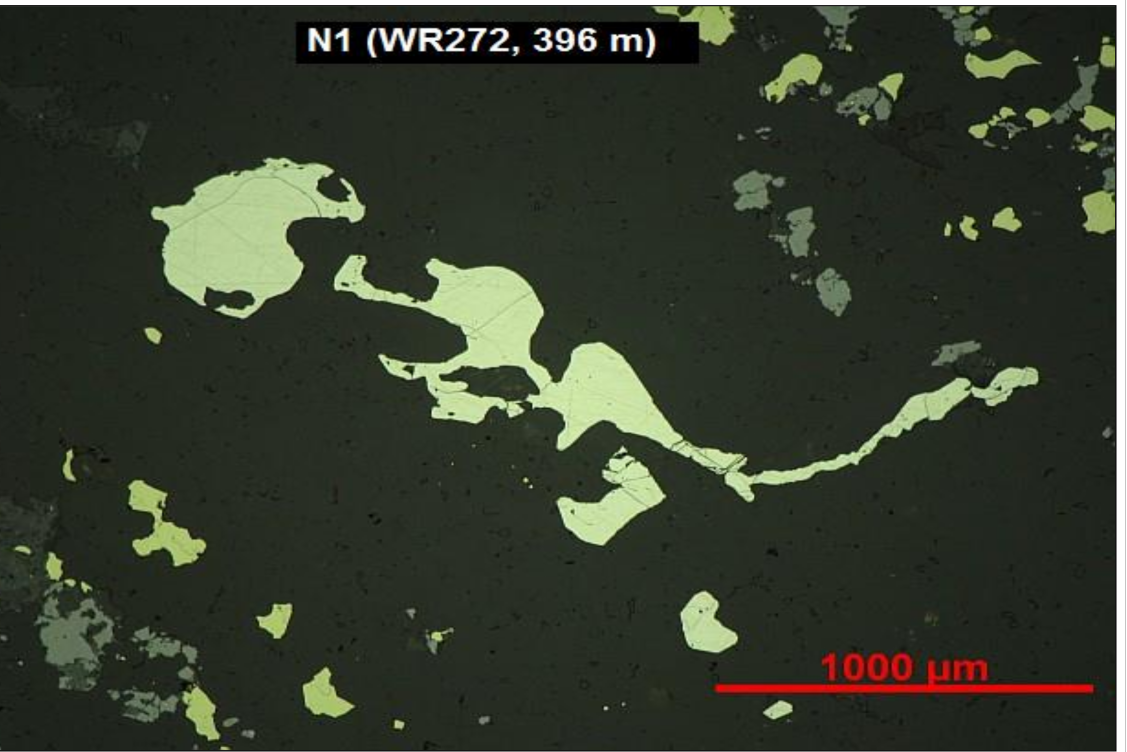
Figure 9. Photomicrograph of pyrite crystals from sample N1 (i.e., drill hole = WR272, depth = 396.00 m). Pyrite crystals commonly have granoblastic